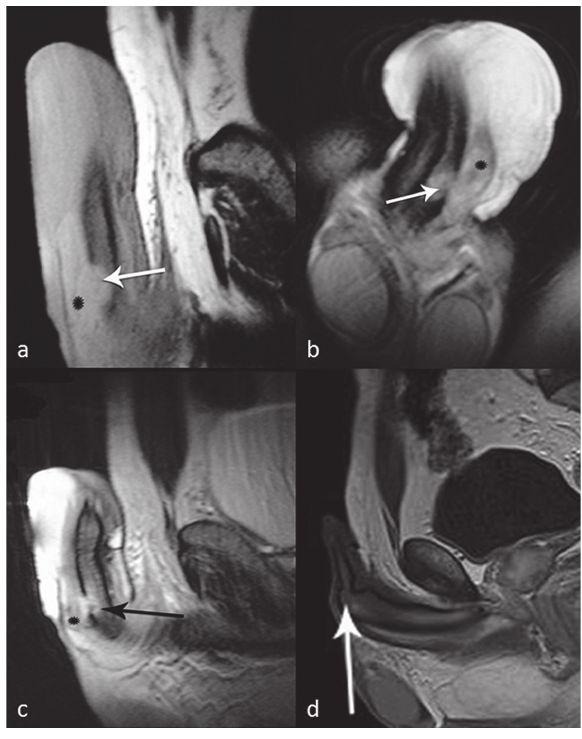
Figure 1 - A 37-year-old patient with penile fracture of the left corpus cavernosum. (a) Sagittal T1-weighted image shows a rupture of the tunica albuginea (arrow) and a haematoma extending into the corpus cavernosum (asteriks). Coronal (b) and sagittal (c) T2-weighted images show also disruption of tunica albuginea (arrow) with surrounding haematoma in the distal penile shaft (asteriks). (d) One year later after surgical intervention the tunica albuginea at the rupture site regains its low signal intensity